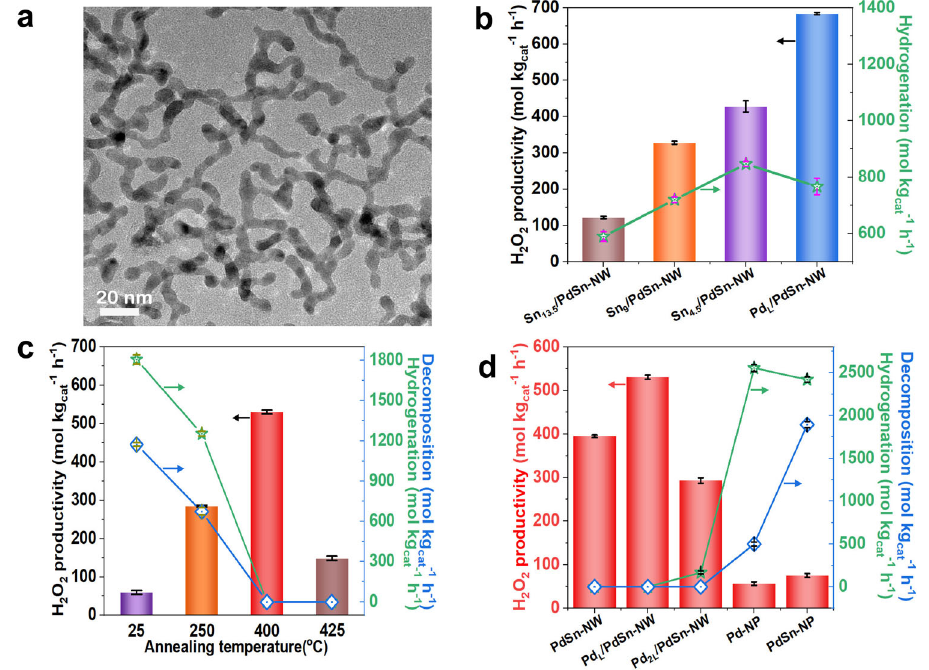
Fig. 2 | Representative TEM image and the catalytic performances of the PdSn nanowire catalysts in the direct H 2 O 2 synthesis (DHS). a Representative TEM image of the unsupported PdSn nanowire catalyst prepared by two-step (unsup- ported Pd L /PdSn-NW). b H 2 O 2 producibility of the supported Pd L /PdSn-NW and Sn x /PdSn-NW catalysts with different Pd/Sn ratios after annealing in air (350°C, 8min),demonstratingtheadditionofSnhasnegativeeffectontheproducibilityof H 2 O 2 . c H 2 O 2 producibility, hydrogenation, and decomposition of the supported Pd L /PdSn-NW catalyst annealing at different temperatures in air, showing that the